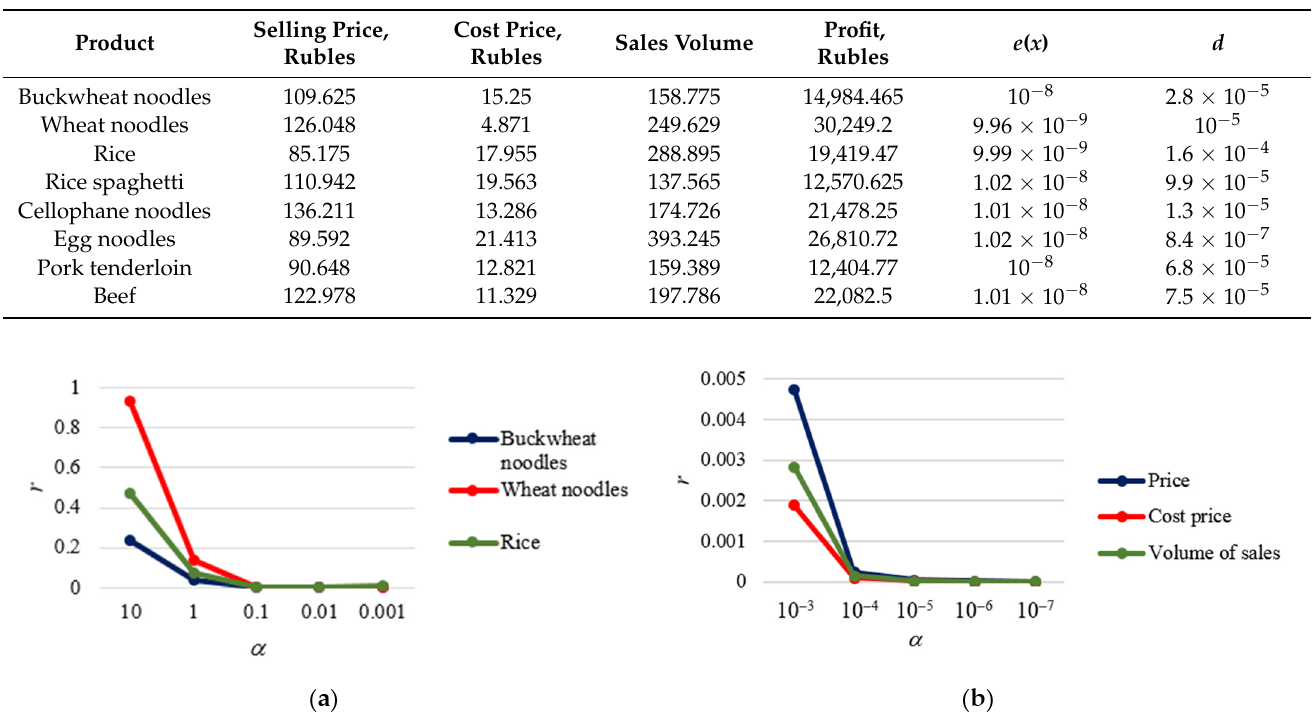
Table 3. The calculated values of factors when using relative importance coefficients and directions of change (for the first level, α = 10 − 4 ; for the second level, α = 10 − 6 ).